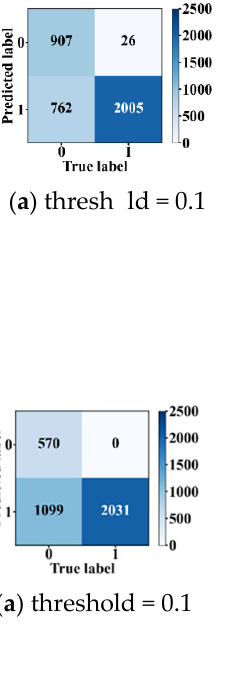
Figure 17. Comparison regarding ROC curve and AUC value between the Faster R-CNN model de- veloped by the experimental dataset with image size 1280 × 720 and noise intensity 0, and the YOLOv4 model developed by the experimental dataset with image size 480 × 480 and noise intensity 0. ( a ) Initial leak ( d ) End leak Figure 18. Visualization examples of the Faster R-CNN model developed by the image size 1280 × 720 dataset under the Co. L. Mar. dataset. ( a ) White plume